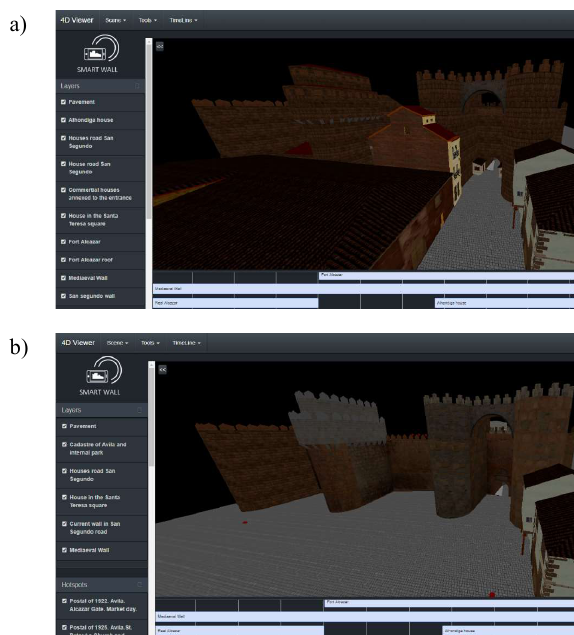
Figure 8. Appearance of the homage tower before and after the intervention of the architect Enrique Mª Repullés y Vargas.